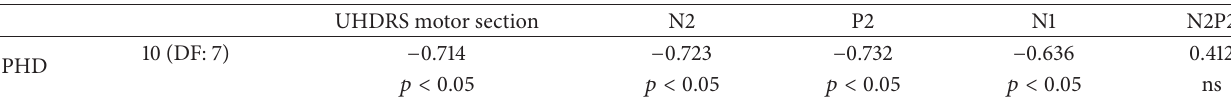
Table 3: Partial correlation test between laser evoked potentials latencies and amplitudes and expected time of illness onset in 10 presymptomatic HD (PHD) cases (age effect was subtracted). UHDRS: Unified Huntington’s Disease Rating Scale.